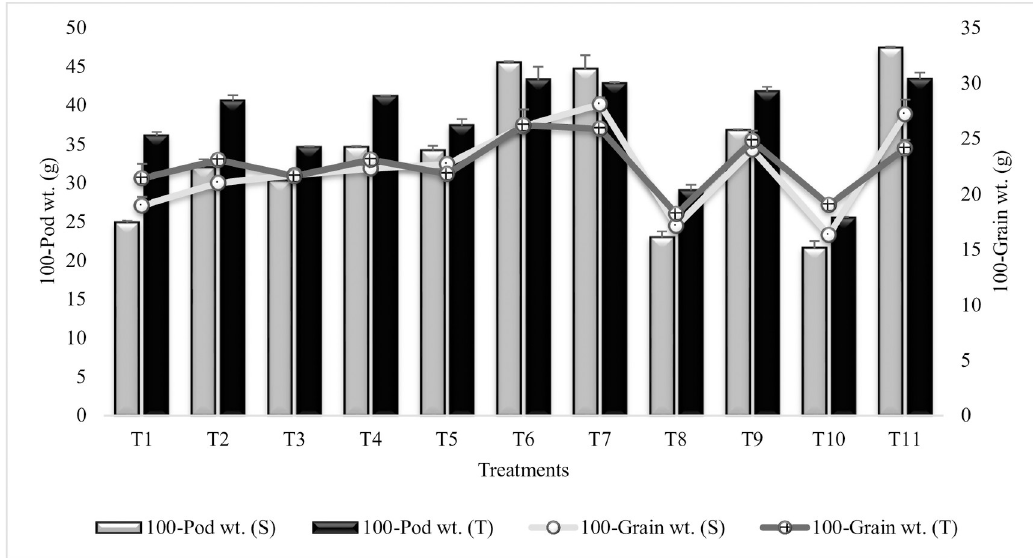
Fig 12. 100-pod and grain weight of chickpea grown in sandy soil. Data are means of four replicates along with standard error bars (S-Sensitive Variety; T-Tolerant Variety).